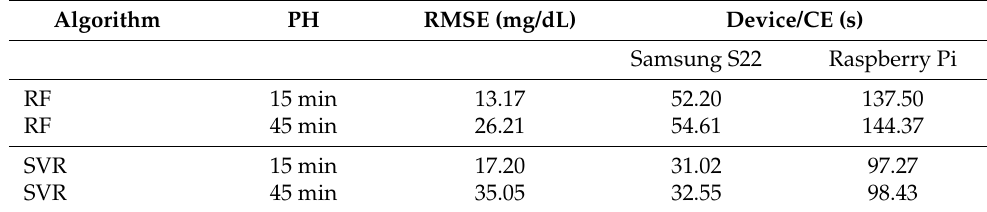
Table 3. RMSE and CE according to algorithm and